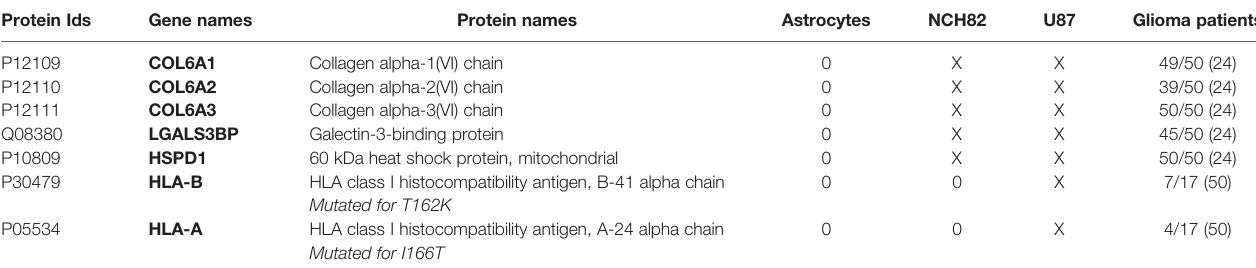
TABLE 1 | Expression of surface proteins in GBM patients. Protein